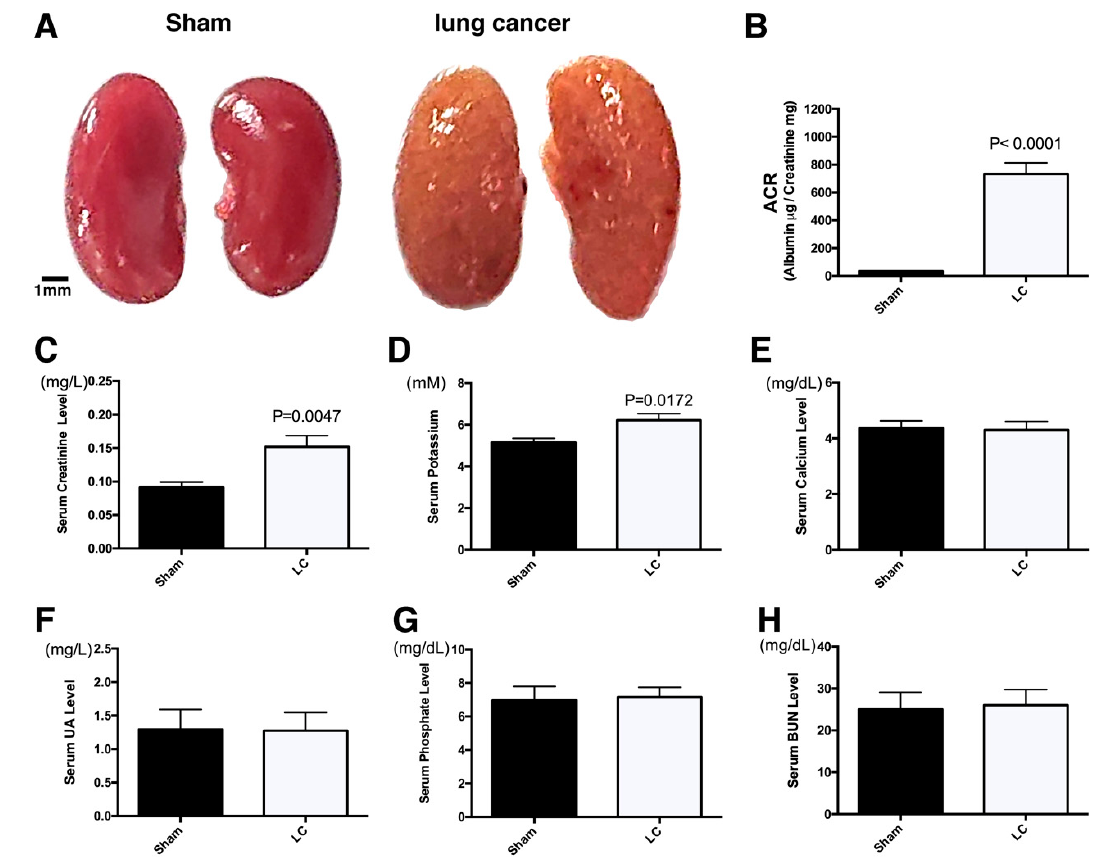
Figure 1. Orthotopic xenograft LLC1 (Lewis lung carcinoma 1) cells led to kidney injury. ( A ) Kidneys in the mice bearing lung cancer were pale and yellow-brownish in color anatomically (bar = 1 mm). ( B ) High urine ACR (albumin-creatinine ratio) was detected in the lung cancer mice. ( C ) Serum creatinine levels were slightly higher in the lung cancer mice than in the sham group. ( D ) After LLC1 implantation, the serum potassium level was slightly elevated. ( E ) Serum calcium levels were similar in the lung cancer and sham mice. ( F ) Serum uric acid (UA) levels were not elevated in the lung cancer mice. ( G ) The lung cancer and sham mice had similar serum phosphate levels. ( H ) The blood urea nitrogen (BUN) level was not obviously increased in the lung cancer mice.